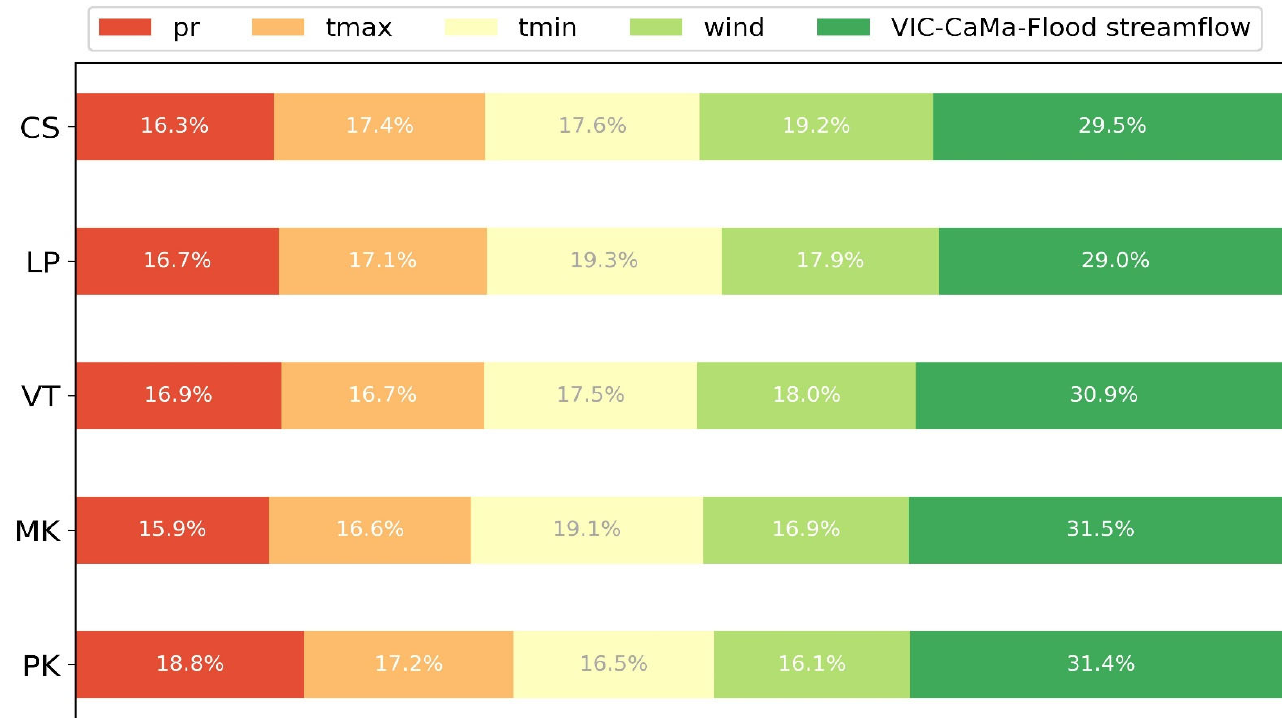
Figure 7. Importance of HPD model inputs (pr, precipitation; tmax, maximum temperature; tmin, minimum temperature; wind, wind speed; VIC-CaMa-Flood streamflow, streamflow simulated by VIC-CaMa-Flood model) at five selected stations in the training period.